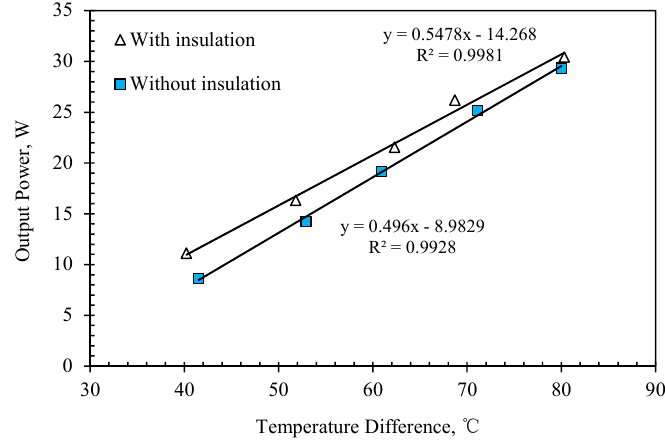
Figure 9. The effect of heat-insulation on output power.